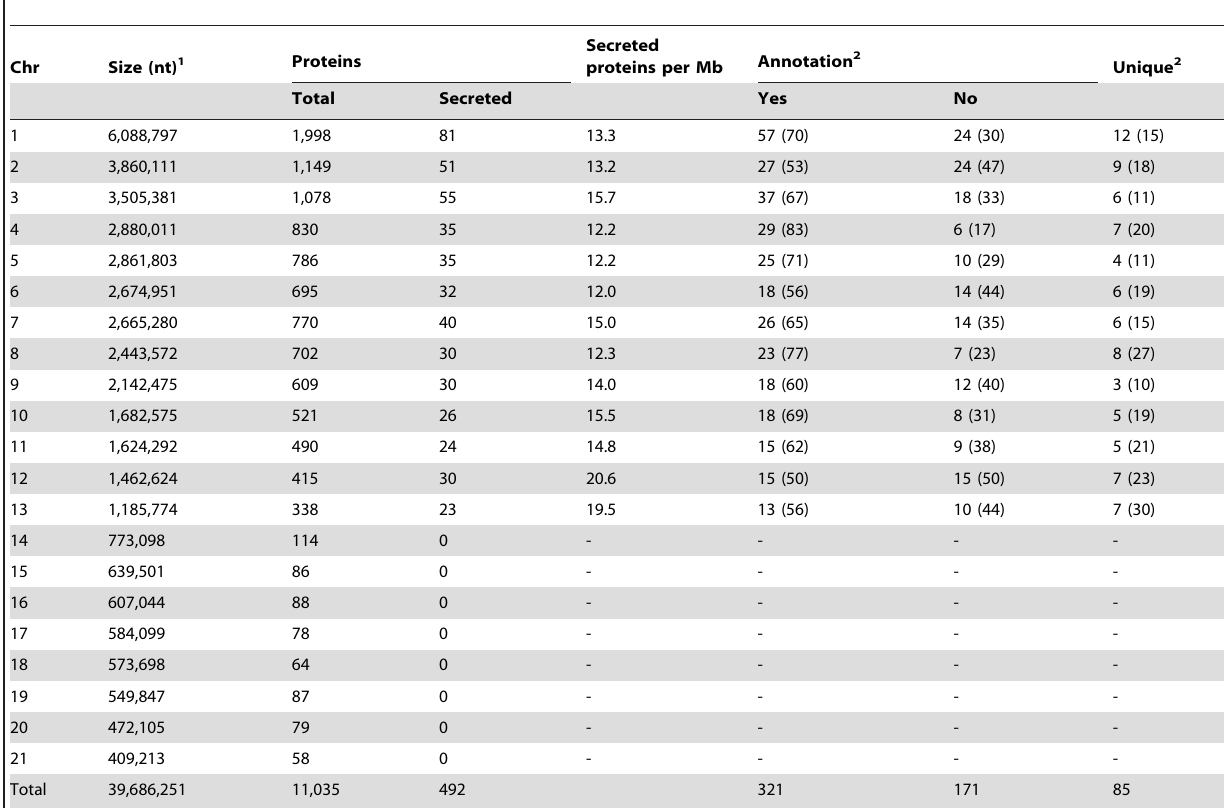
Table 1. Distribution of secreted proteins throughout the 21 chromosomes of Mycosphaerella